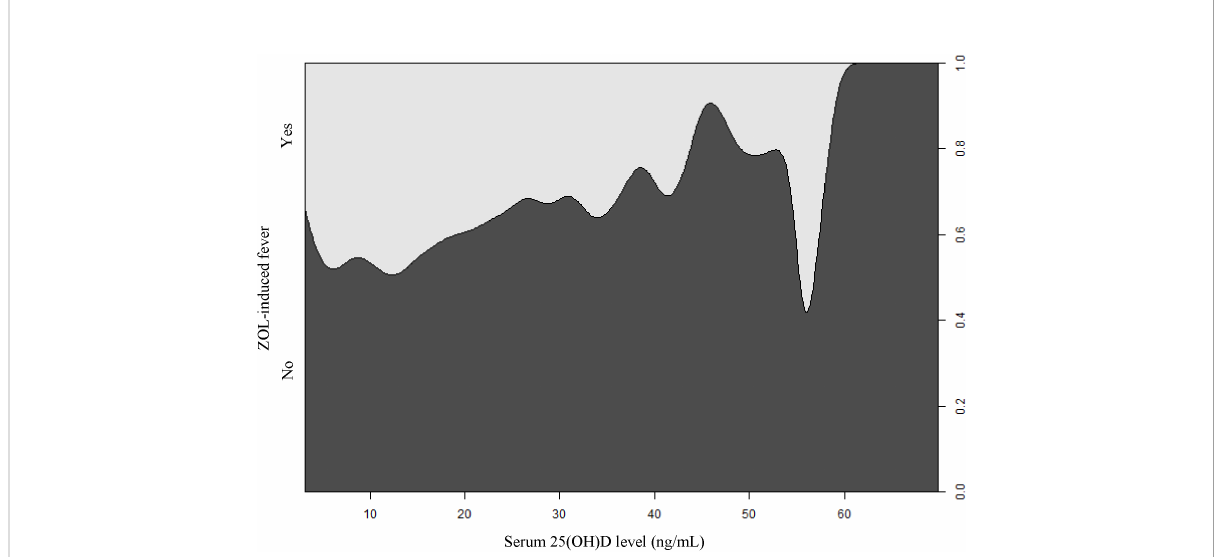
FIGURE 2 The conditional density plot depicting the correlation between serum 25(OH)D levels and ZOL-induced fever. 25(OH)D, 25-hydroxy vitamin D; ZOL,